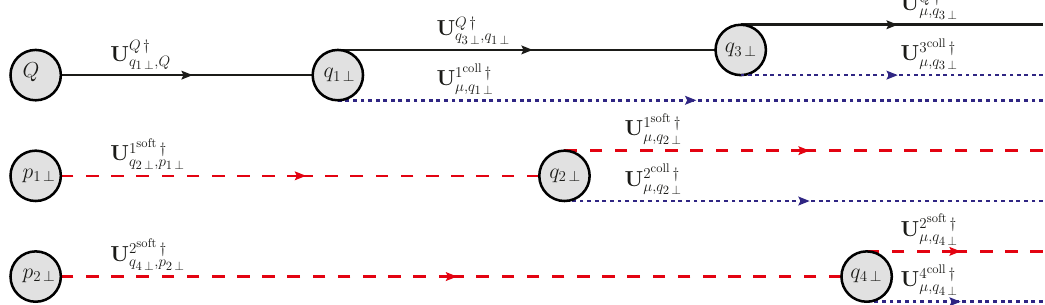
Figure 5. One of the possible contributions to tCol y blue dotted lines represent collinear partons. Each line is associated with a Sudakov factor and circles indicate the scale from which the subsequent evolution proceeds. Circles from which two lines leave indicate the action of the operator ~ C . Circles from which one line leaves indicate the scales inherited from the soft evolution phase (not shown). Collinear scales respect to each other, as are soft scales the largest to the left and smallest to the